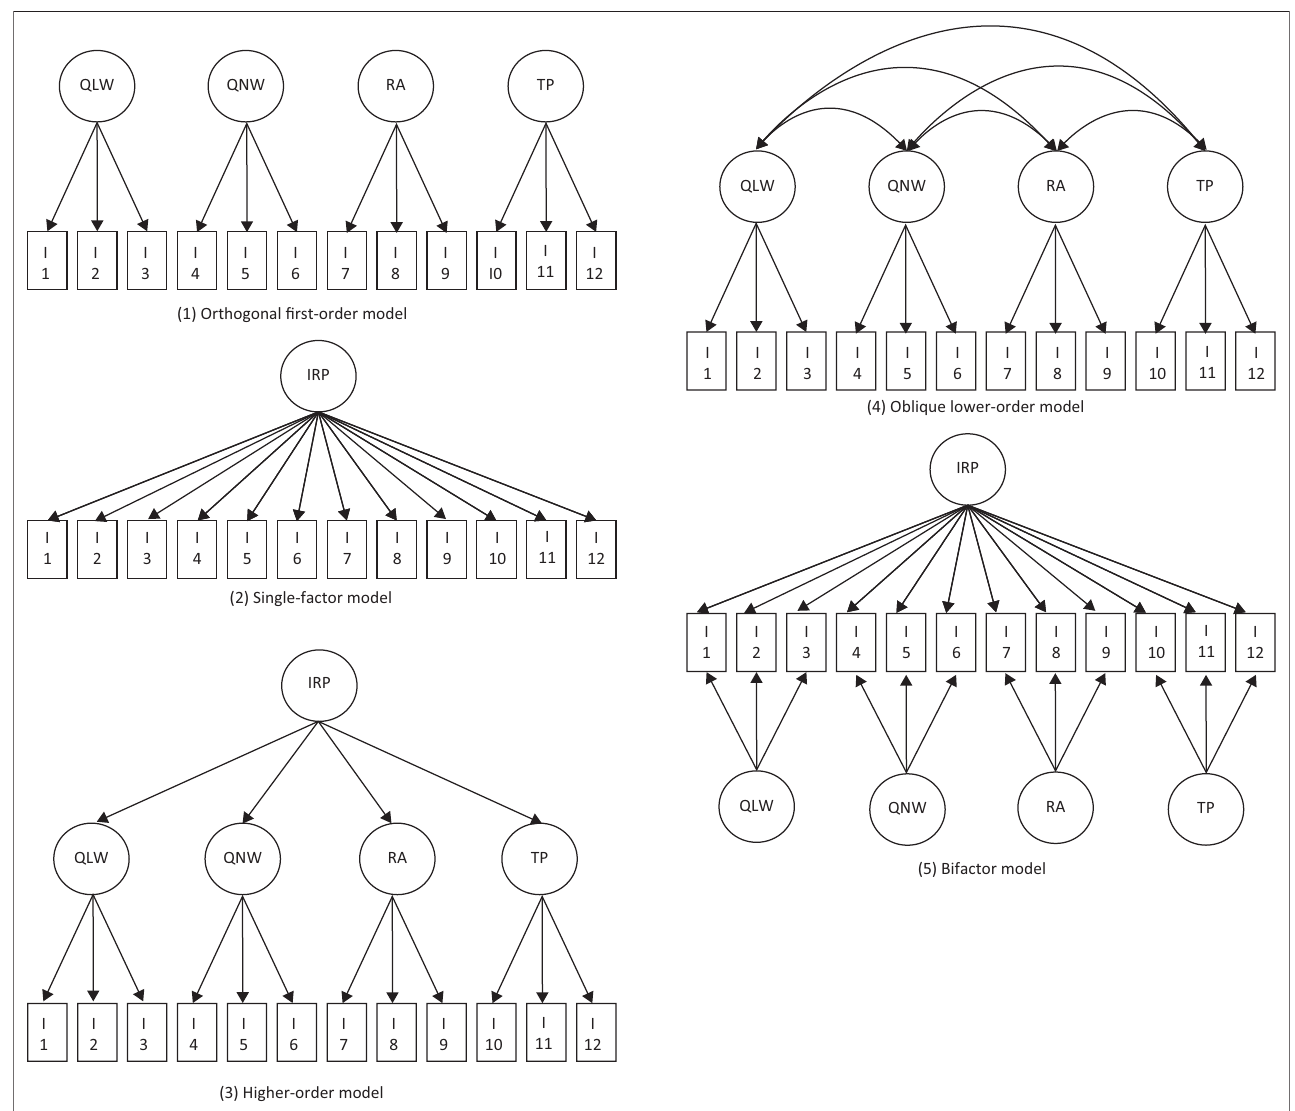
FIGURE 1: Factor structures of in-role performance based on guideline of Credé and Harms